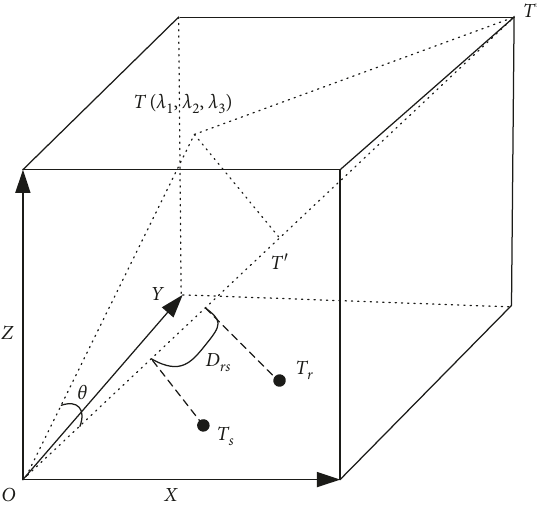
Figure 3: Vector-cosine method in three-dimensional space.